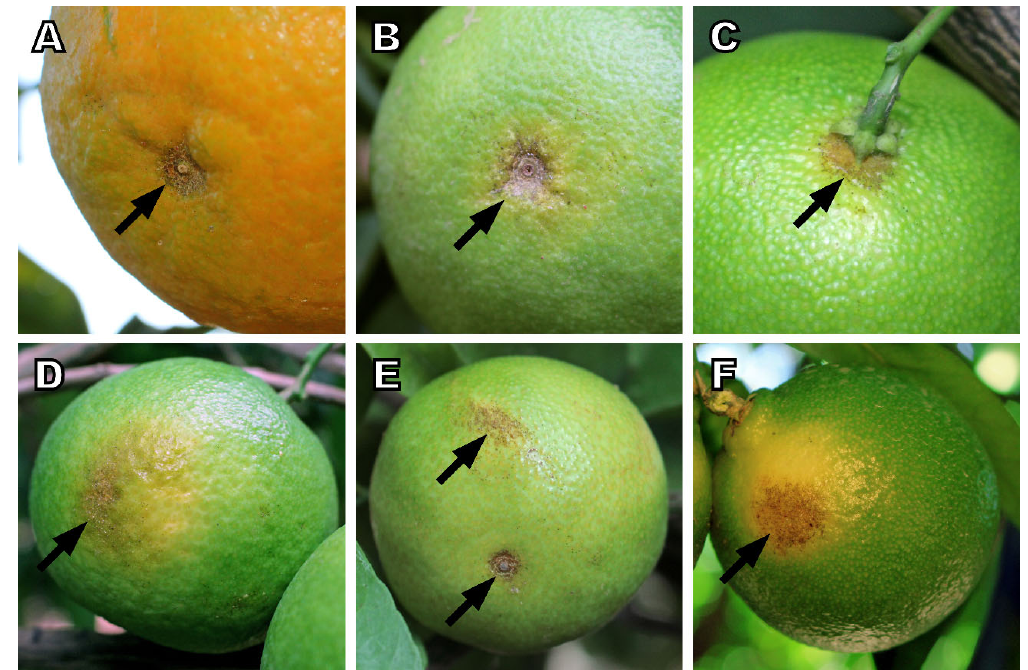
Figure 3. Fruits with damage caused by Tetranychus urticae (indicated by arrows). ( A – C ) Light damage and ( D – F ) severe damage.